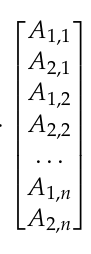
Moreover, the shear between the two contacted faces in the adjacent segments should